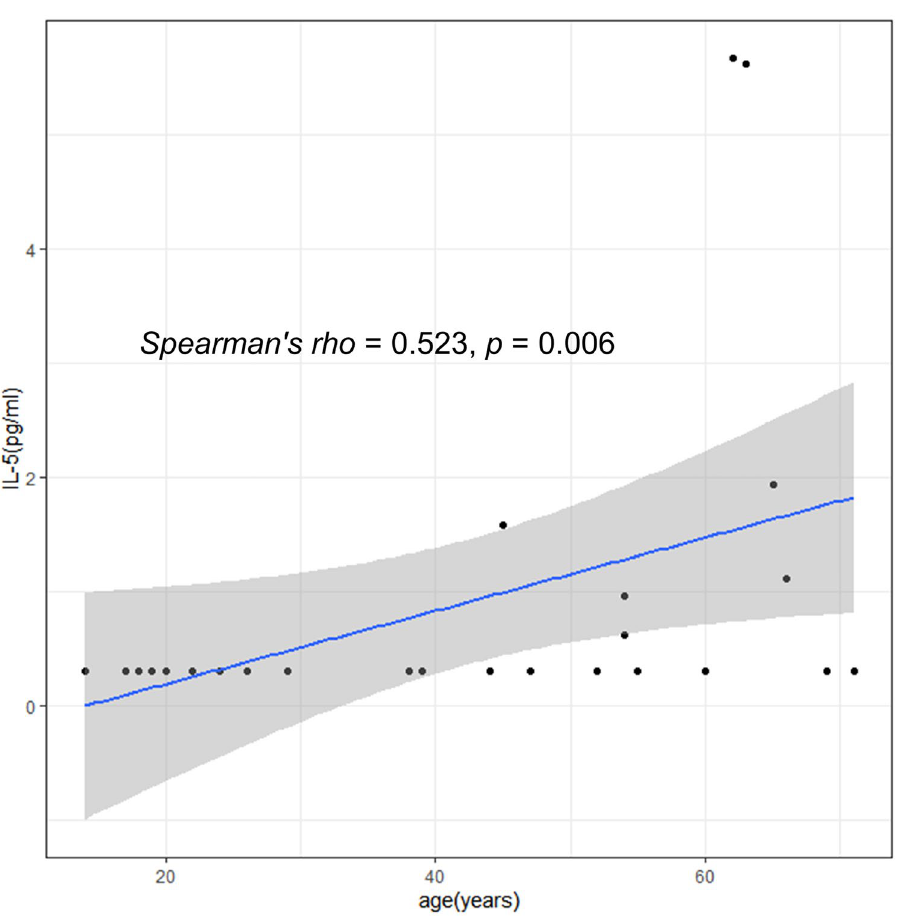
Figure 4. Correlation bewteen tissue IL-5 level and age in patients with non-eosinophilic chronic rhinosinusitis with nasal